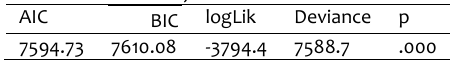
Table 2. Fit indices of the model